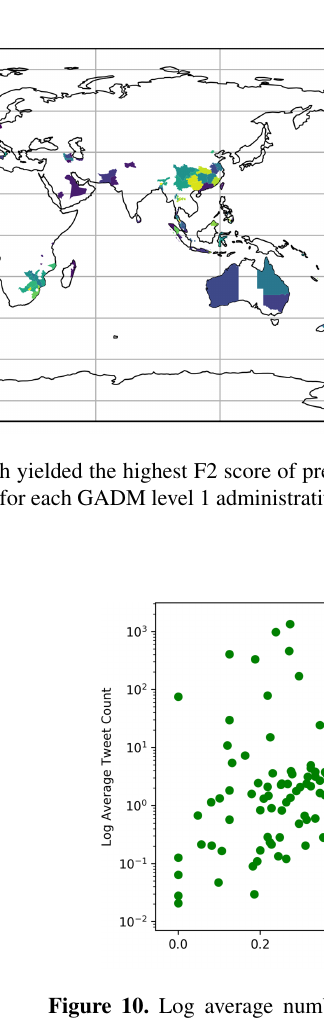
Figure 10. Log average number of tweets versus the maximum F2 score for each location with an event in the Met Office